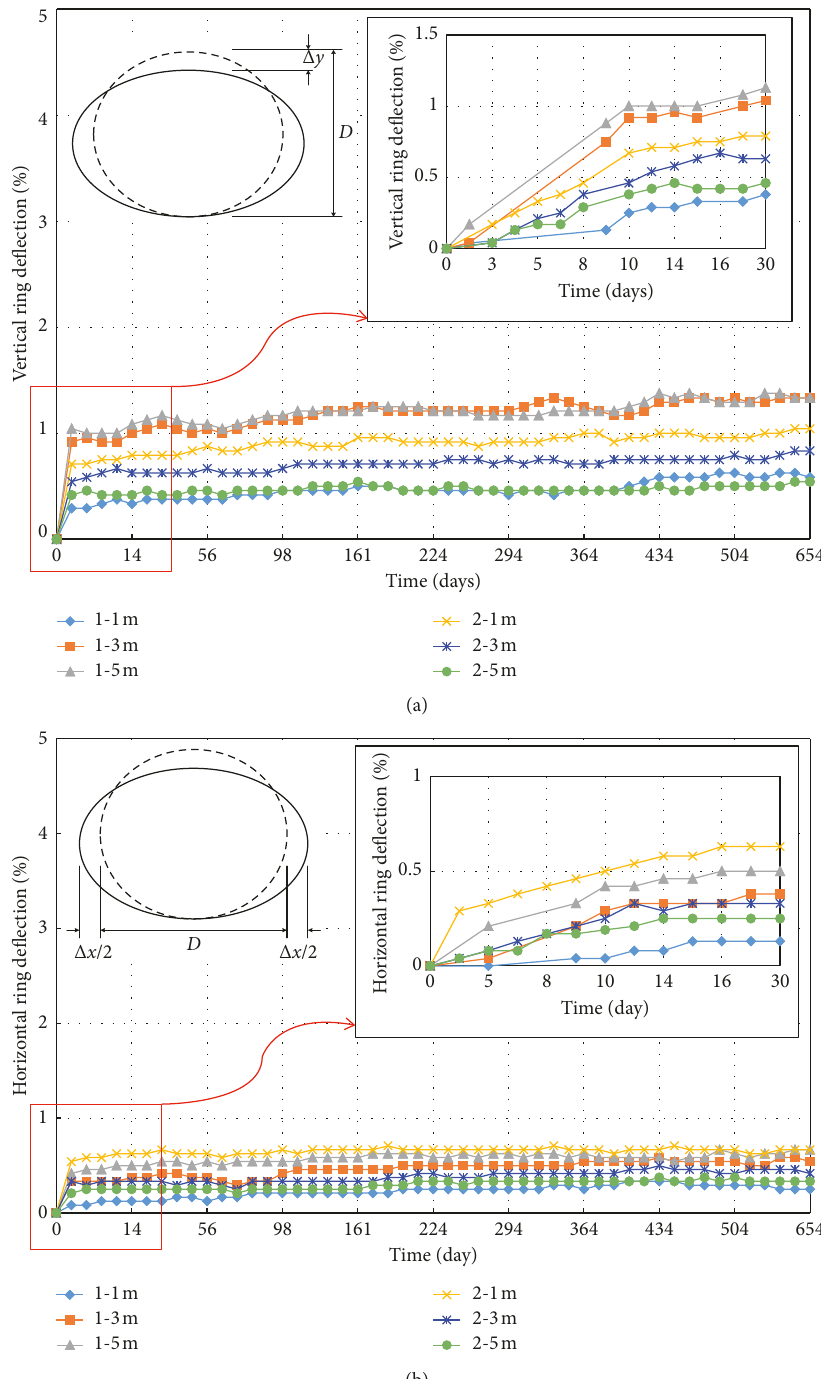
Figure 6: Measured deflections for the underground GFRP